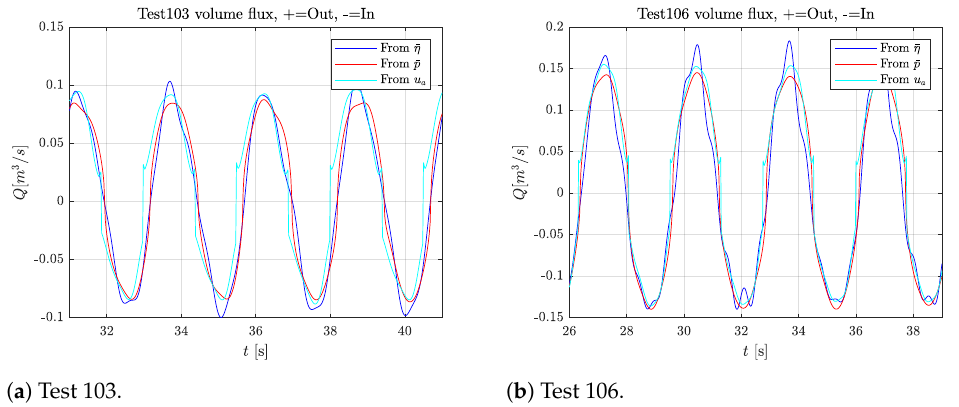
Figure 10. Estimates of the measured volume flux for two cases based on measurements of the mean chamber surface elevation (from ¯ η ), the pressure and Equation (6) (from ¯ p ) and the air flow velocity through the orifice (from ¯ u a ). A positive flow rate represents air flowing from the chamber to the atmosphere.